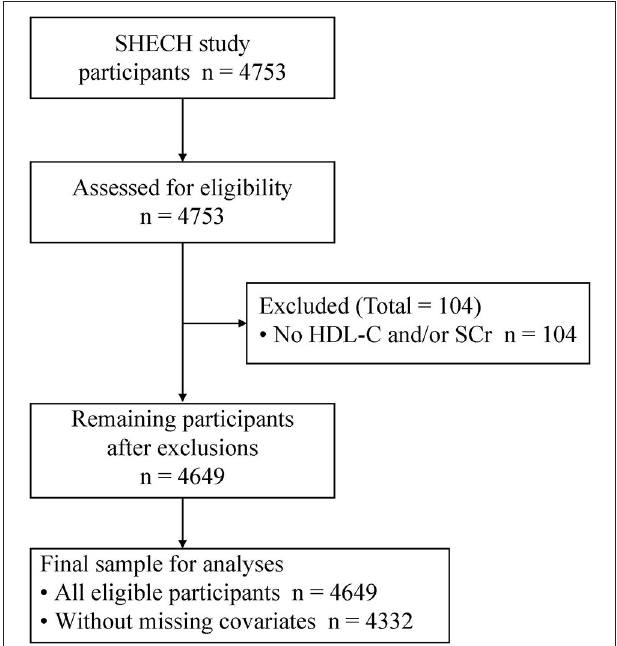
FIGURE 1 | Study flow. HDL-C, high-density lipoprotein cholesterol; SCr, serum creatinine; SHECH, Shanghai Elderly Cardiovascular